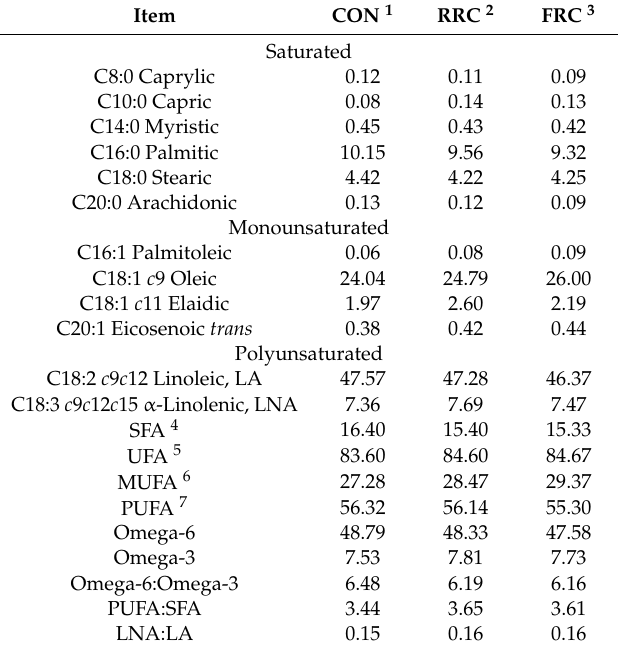
Table 3. Fatty acid profiles of diets containing raw rapeseed cake (RRC) and fermented rapeseed cake (FRC) fed to the broiler chickens (g / 100 g FA); experiments 1, 2, and 3.